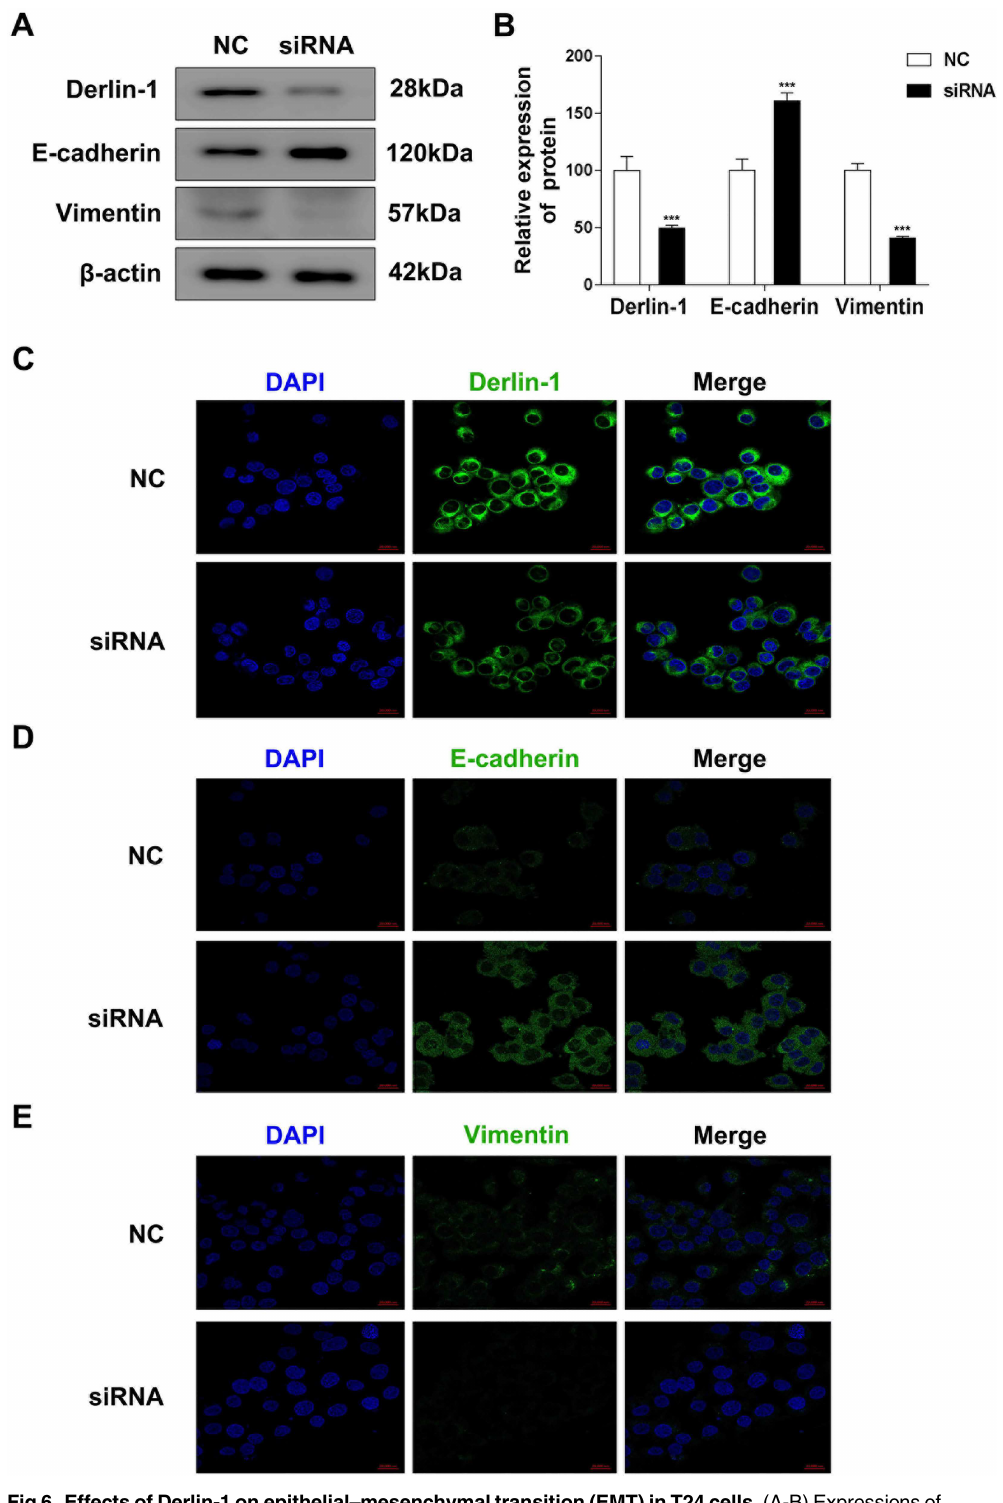
Fig 6. Effects of Derlin-1 on epithelial–mesenchymal transition (EMT) in T24 cells. (A-B) Expressions of E-Cadherin and Vimentinby Western blot assay in T24 cells transfected with Derlin-1siRNA. β -actin was probedas the loadingcontrol. *** P < 0.001, comparedwith negativecontrol. (C-D) Expression of Derlin-1,E-Cadherinand Vimentin( red ) by immunofluorescence staining analysisusing confocalin T24 cells transfected with Derlin-1 siRNA. The nuclei were stained with DAPI ( blue ).scale bar: 5 μ